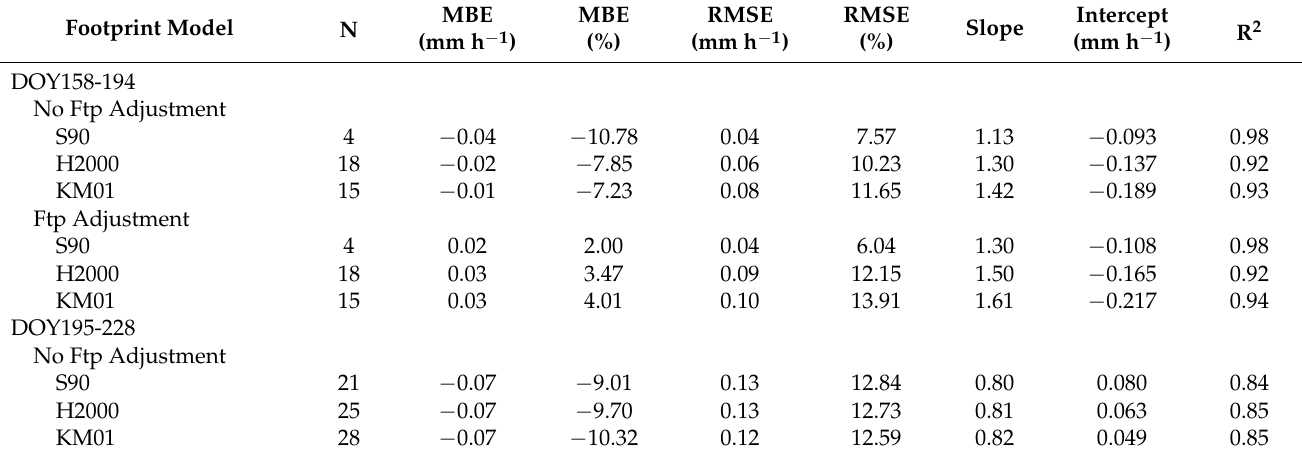
Table 7. Comparison of the footprint corrected ET from EC8 to the Lysimeter (NE) ET for the different growth stages, and for the entire study period. Footprint